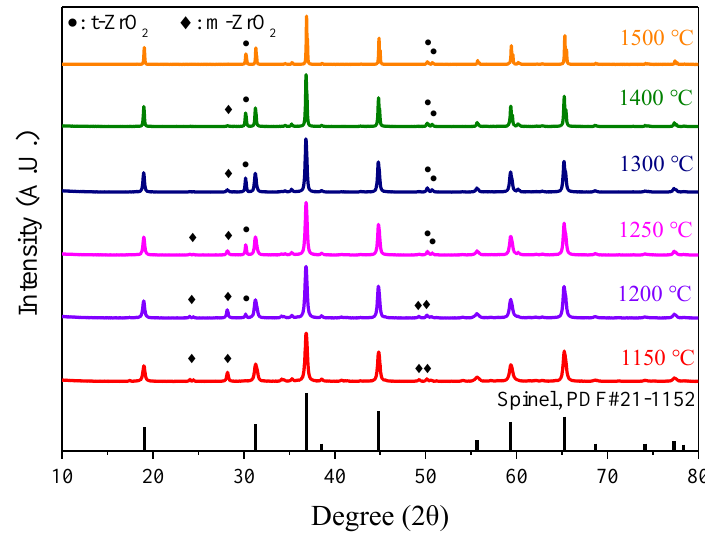
Figure 6. XRD patterns of spinel powder with 5 wt% ZrO 2 as a function of calcining